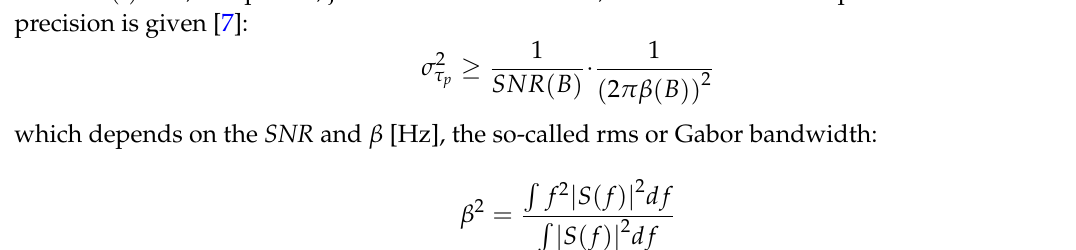
Table 1. Altimetry rms error estimated by combining L1/E1 and L5/E5 bands to correct for the ionospheric delay at nadir and at an incidence angle of 35 ◦ (swath edge) (modified from [6]). LB = 1186.6 MHz and LH = 1575.42 MHz. Requirement is for σ h < 30 cm rms over 100 km dwell line. Altimetry Precision [cm rms ]